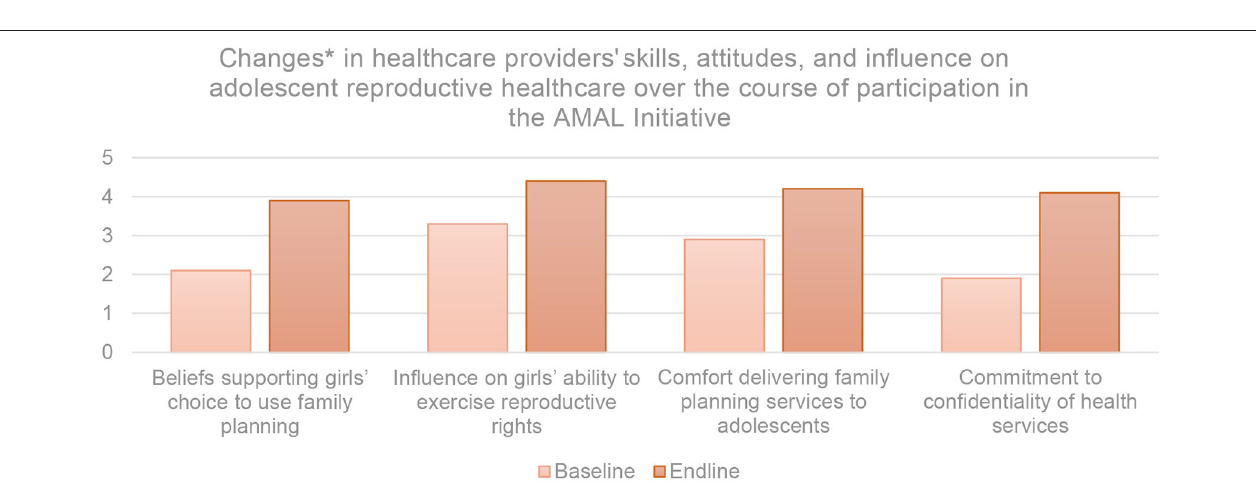
FIGURE 4 | Consolidated changes between baseline and end line in AMAL healthcare provider participants’ self-report of their skills in, attitudes toward, and influence on adolescent reproductive healthcare on a five-point Likert Scale. *Measured through a consolidated analysis of norms statements using five-point Likert Scale wherein 1, strongly disagree; 2, disagree; 3, neutral; 4, agree; and 5, strongly